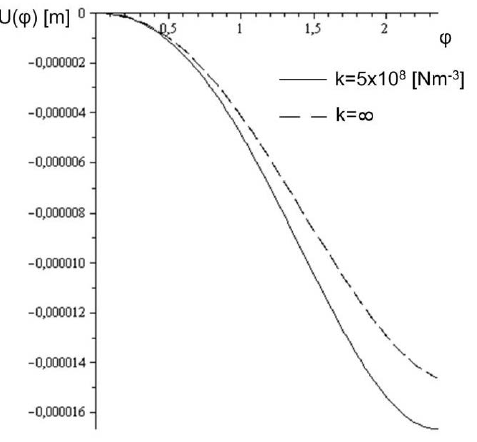
Figure 9: Plots of radial displacement for Example 1.